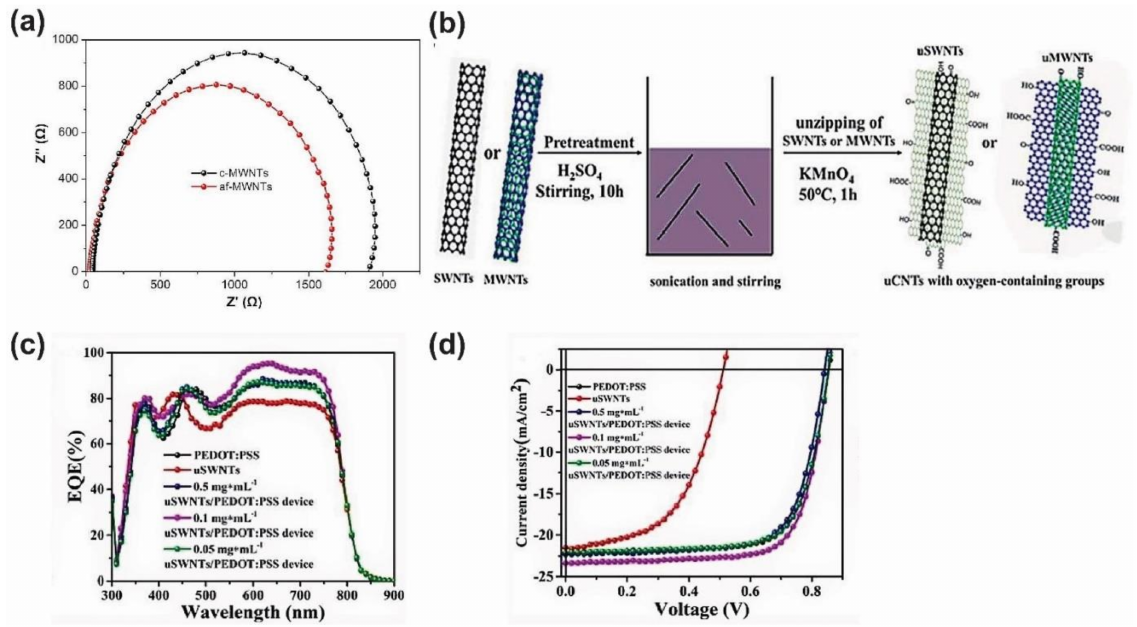
Figure 13. ( a ) Impedance spectra of OSCs with c-MWNTs and af-MWNTs HTLs. Adapted with